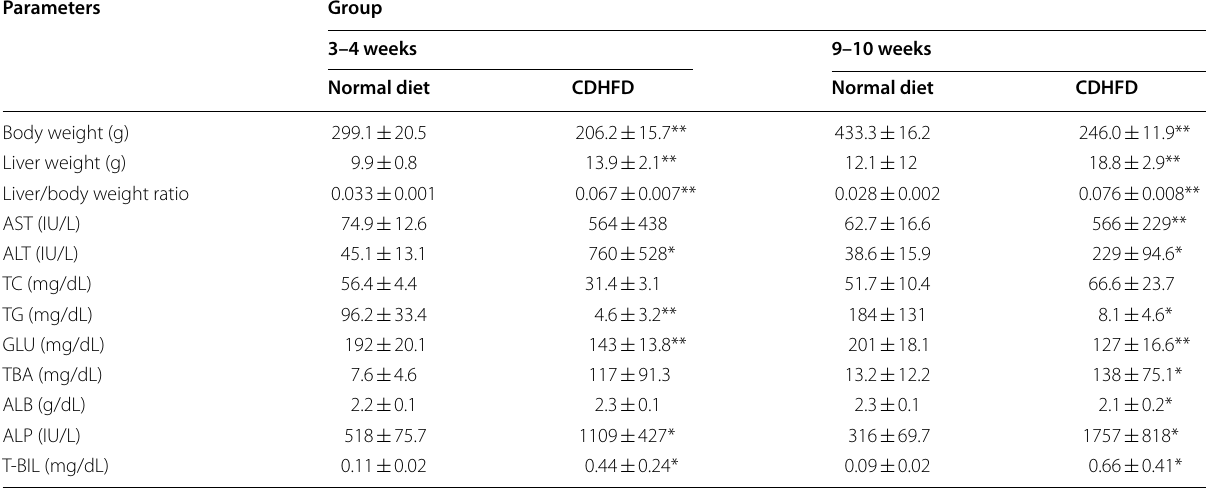
Table 1 Body and liver masses, liver/body mass ratio and biochemical parameters Parameters